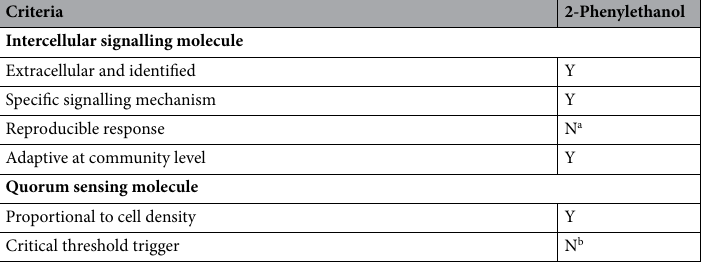
Table 3. 2-phenylethanol does not act as an intercellular signaling and quorum sensing molecule to induce the change in budding pattern based on our experimental results. Criteria from 24 . a Response only observed when 2-phenylethanol used at much higher concentrations (20 µM) than found to be physiologically produced (0.7–1.5 µM). b Since the response is only induced at high levels it may be a starvation or stress response and not a QS